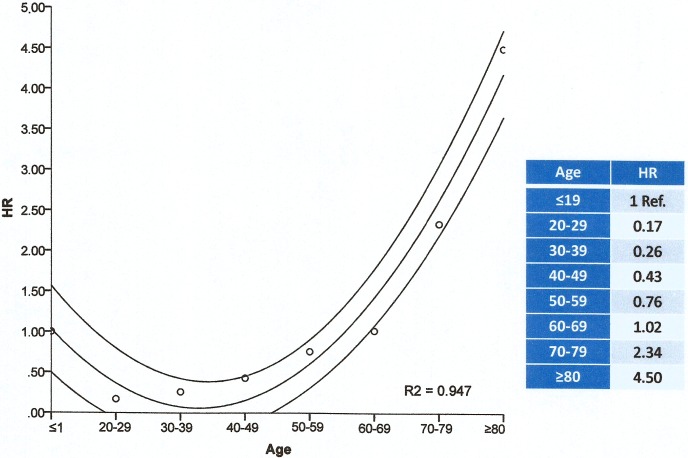
Correlation between group of age and HR value, obtained by Cox model.HR indicates hazard risk and R2explains the great correlation between HR and age, with less than a 5% error.